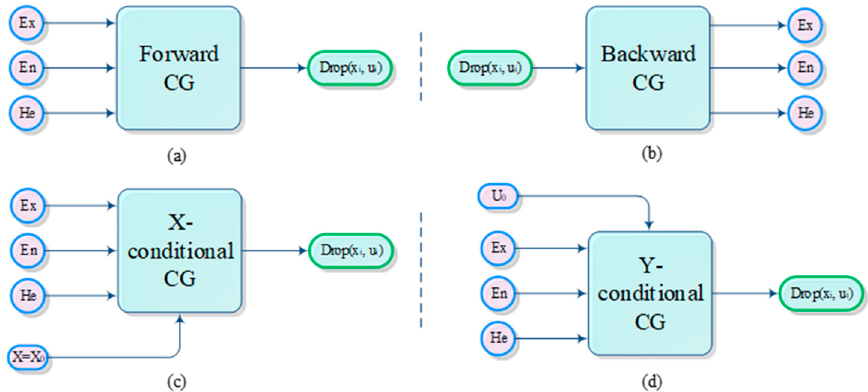
Figure 2. Schematic diagram of cloud generator. ( a ) Forward CG. ( b ) Backward CG. ( c ) X-conditional CG. ( d ) Y-conditional CG.